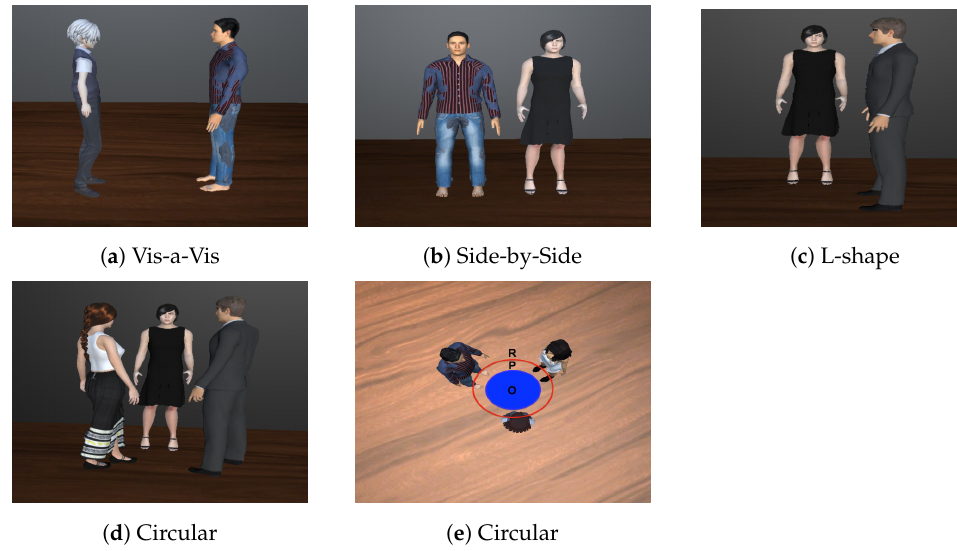
Figure 2. ( a – d ) present the four F-formations. ( d , e ) represent the same circular formation, ( d ) presents the ego-centric view, and ( e ) presents the top view. F-formations define three spaces. O-space is the empty space between people involved in the interaction. P-space is the narrow strip on which people stand while conversing. R-space is the space beyond the P-space, as seen in ( e